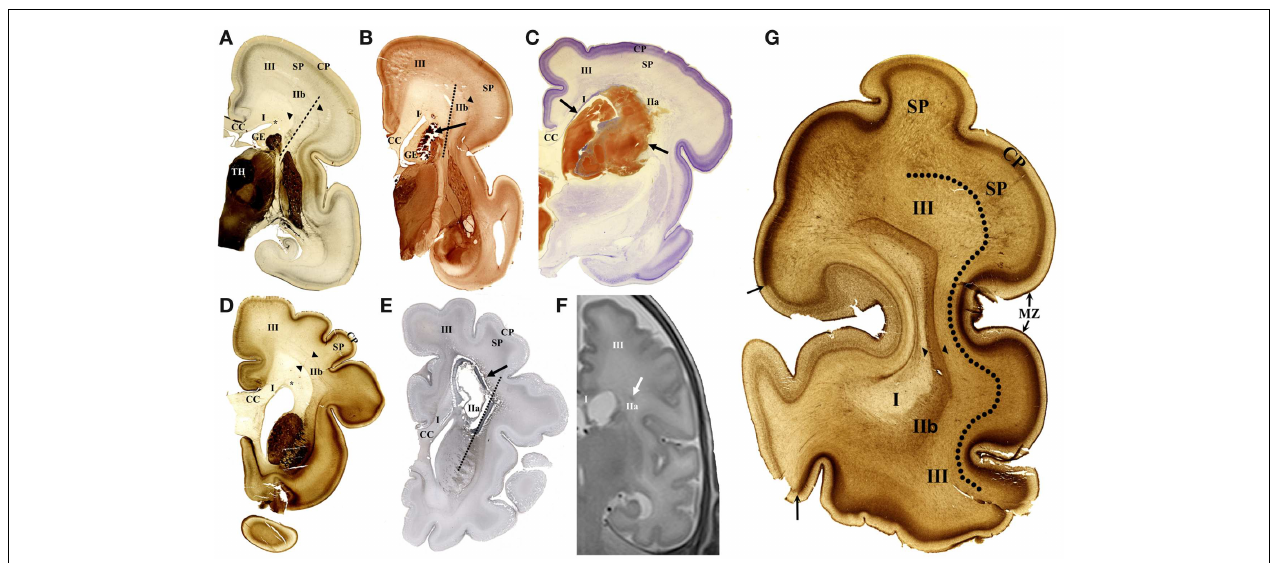
WMS I and IIa. In late preterm, cystic lesion is shown extending throughout WMS I and IIa (E) . Small hemorrhagic lesion is located inWMS IIa on in vivo MR image (F) . AChE histochemistry shows main compartments andWM segments on coronal section through occipital lobe (G) . Periventricular compartment, includingWMS I, is followed in radial direction with sagittal strata (WMS IIb, between arrowheads). Next compartment, centrum semiovale (III) is delineated from subplate (SP) with broken line. Arrows indicate border between primary visual cortex (light staining) and area 18 (heavy staining).TH, thalamus; SP, subplate; CC, corpus callosum; MZ, marginal zone; asterisk, PVP pathway zone; broken lines (A,B,E) indicate axis of internal